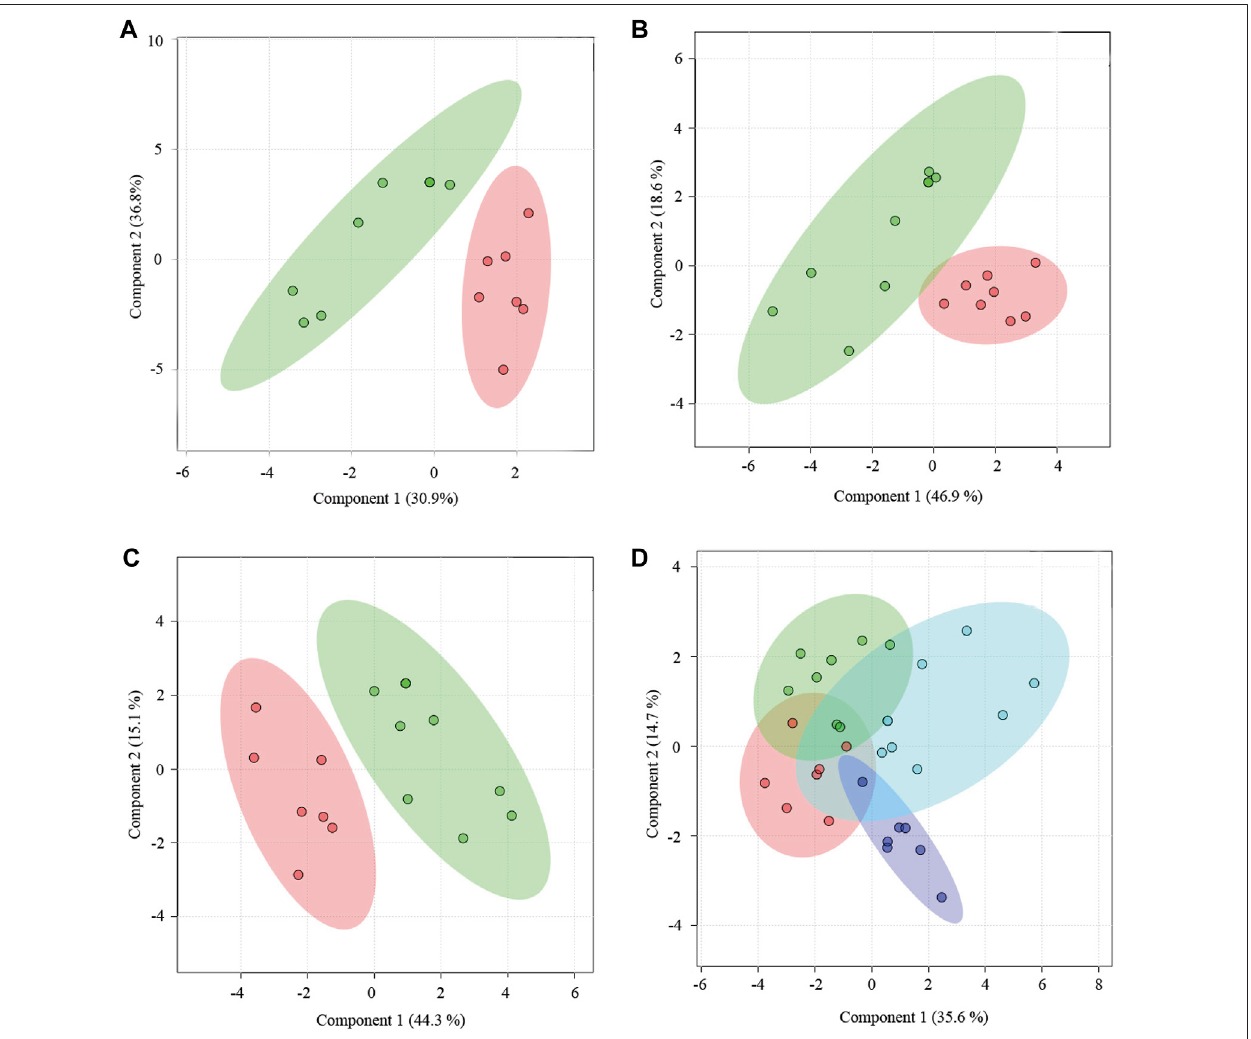
FIGURE 4 | Yougui regulated the metabolomic state of PMS rats. (A) PLS-DA analysis of metabolomic pro fi le from the plasma of PMS rats before (red) and after (green)treatment withYougui. (B) Metabolomic pro fi leoftheplasmaofYougui-treated PMSrats(green)andperimenopausalrats(red). (C) Metabolomicpro fi lefromthe plasma of Yougui-treated PMS rats (green) and that of 6-month-old rats (red). (D) PLS-DA analysis of metabolomics pro fi les from the plasmas of PMS rats treated with (blue) and without Yougui (purple), perimenopausal (green) rats, and 6-month-old rats (red). Yougui treatment modulated the metabolomic state of PMS rats towards that of rats at younger